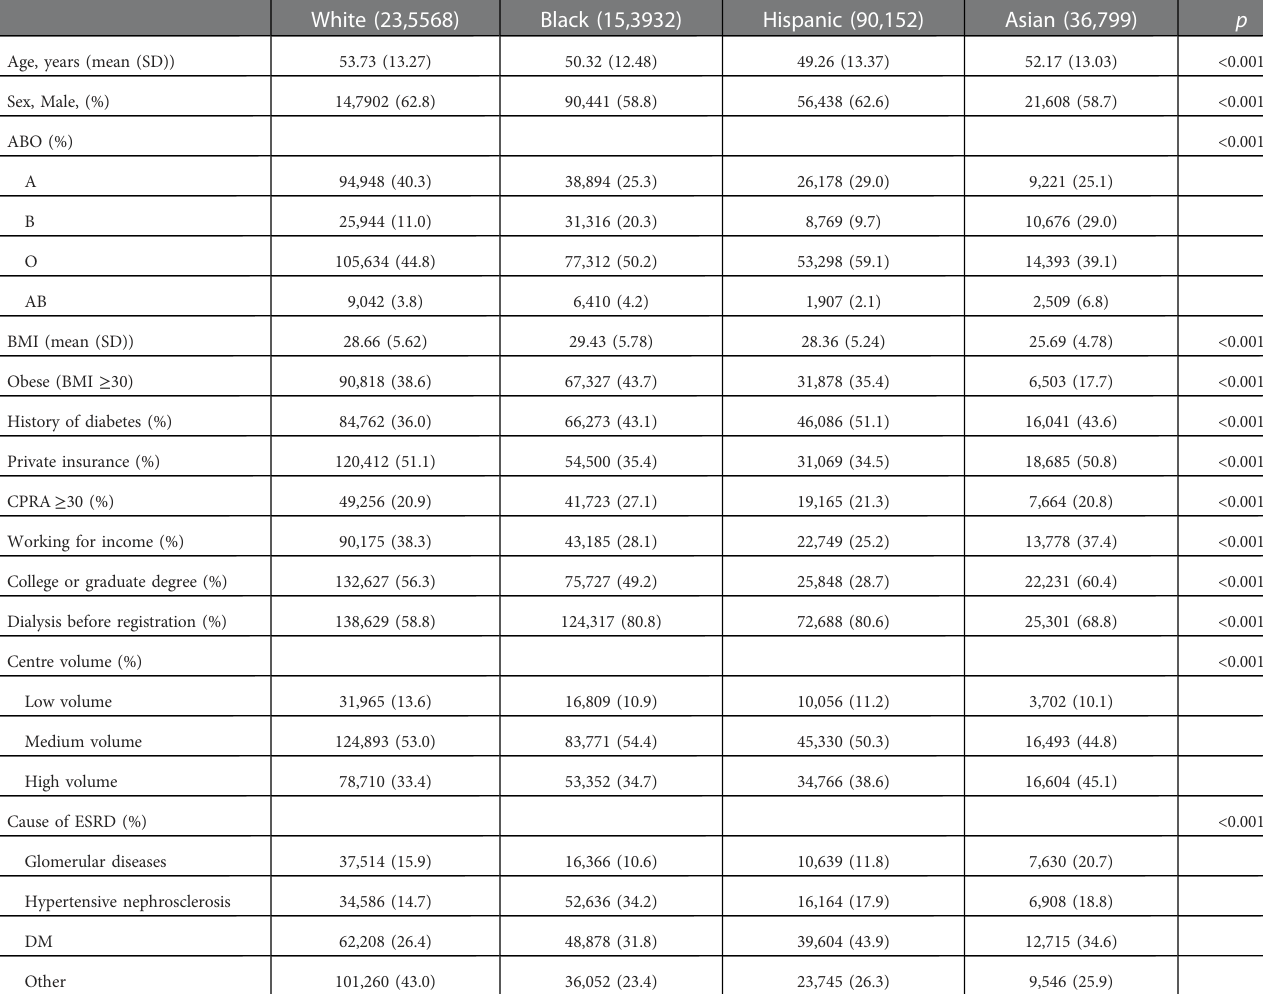
TABLE 1 Baseline characteristics of white, black, Hispanic and Asian patients listed for a kidney